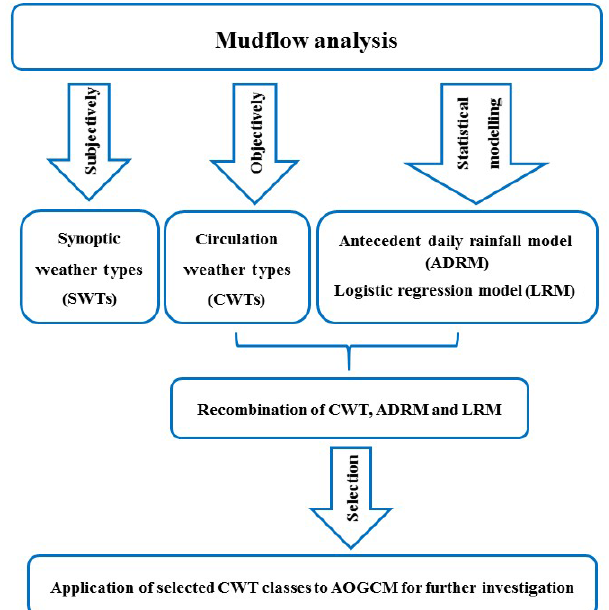
Figure 2. Methodological flow chart of the investigation process presented in this